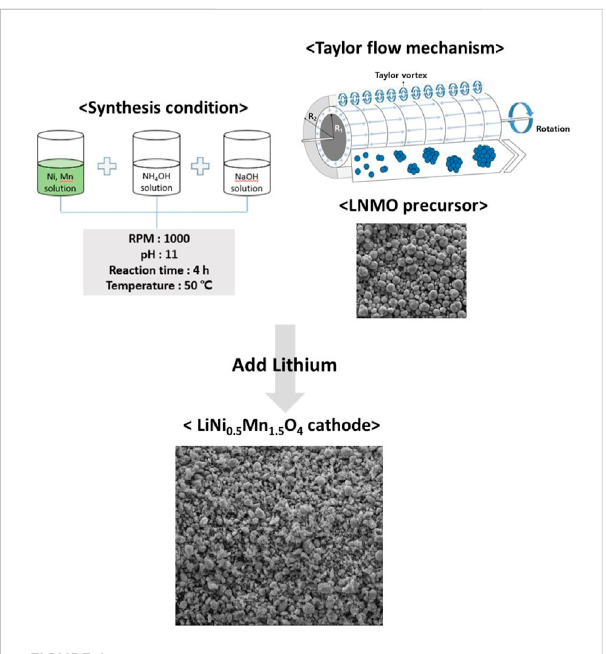
Schematic diagram of synthesis condition of co-precipitation and the Taylor-Couette fl ow mechanism.